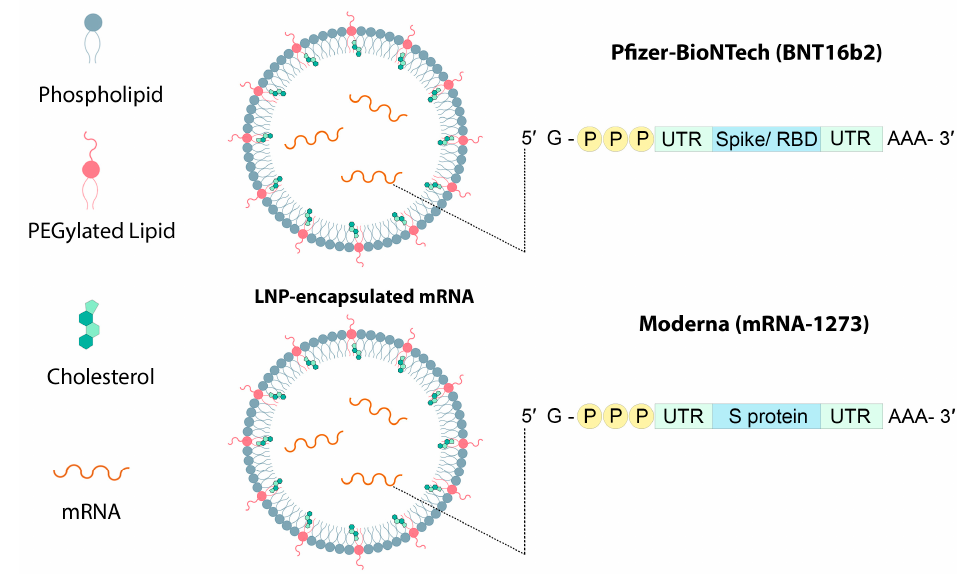
Figure 7. Structure of Pfizer-BioNTech (BNT162b2) and Moderna (mRNA-1273) vaccines.